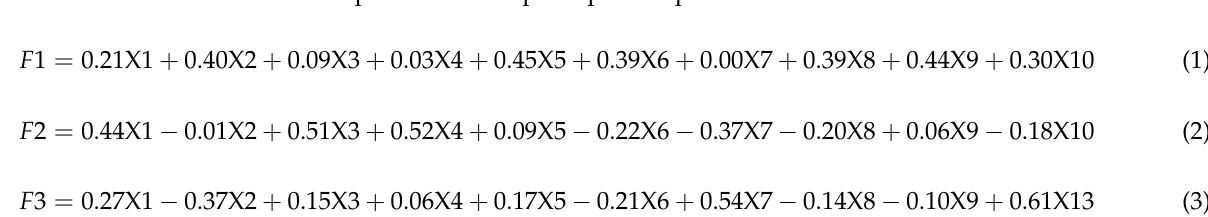
Table 5. Principal component evaluation value and comprehensive evaluation value.